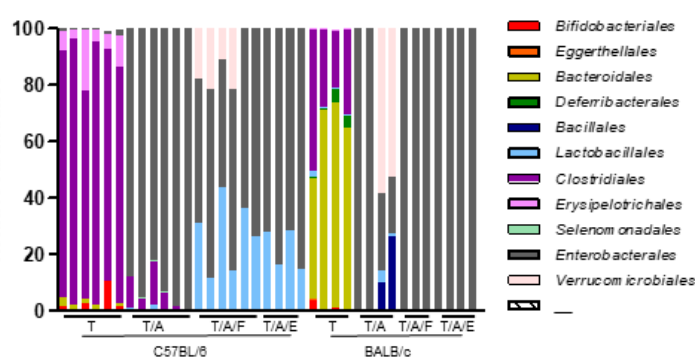
Figure 5. Relative bacterial abundance across mouse strains and treatments. Relative bacterial abundance at the phylum level ( a ), class level ( b ), and order level ( c ). Each bar represents each sample. T: treatment with Tim3VdIg alone; T / A: treatment with Tim3VdIg and antibiotics; T / A / F: treatment with Tim3VdIg, antibiotics, and faecal bacteria; T / A / E: treatment with Tim3VdIg, antibiotics, and Enterococcus hirae .